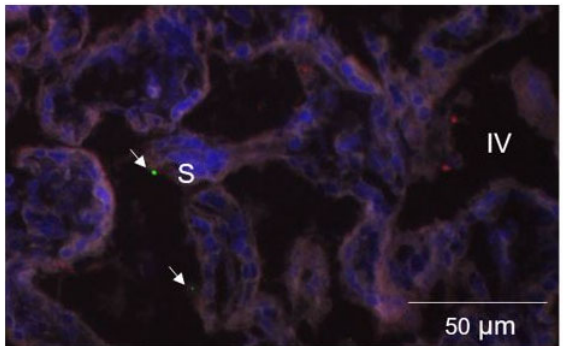
Figure 3. Immunofluorescence of phosphatidylserine-shelled microbubbles (MB-PS). White arrows indicate MB-PS ranging from 1 to 3 µ m. MB-PS were only observed in the intervillous space (IV) and associate with the syncytiotrophoblast. Selectin p positive-stained cells in red are also observed but do not localize with MB-PS. Nuclei shown in blue were counterstained with Hoescht.